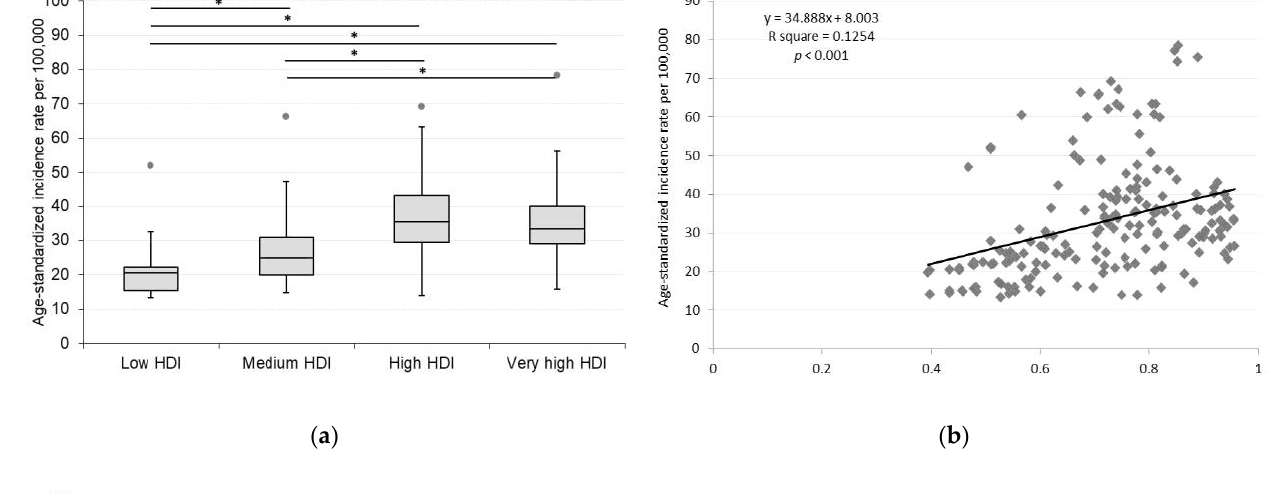
( c ) Figure 1. Time trends in ( a ) age-standardized incidence rates, ( b ) age-standardized mortality rates, and ( c ) age-standardized DALYs rates of CKD from 1990–2019. Dashed lines show the 95% uncertainty intervals. 3.2. Current Disease Burden of CKD According to HDI The distribution of age-standardized rates of CKD according to HDI groups in 2019 is presented in Figure 1a–c. Of the original 204 countries, the HDI data was available for 187 countries in 2019, including 33 low, 37 medium, 53 high, and 64 very high HDI countries. The age-standardized incidence, mortality, and DALYs rates of CKD varied significantly across countries with different human development levels according to the Kruskal–Wallis test ( p = 0.001). According to pairwise comparison, ASIR in low HDI countries differed significantly from medium ( p = 0.007), high ( p < 0.001) and very high ( p < 0.001) HDI countries. In the case of ASMR and age-standardized DALYs rates, only very high HDI countries showed a significant difference from low ( p < 0.001), medium ( p